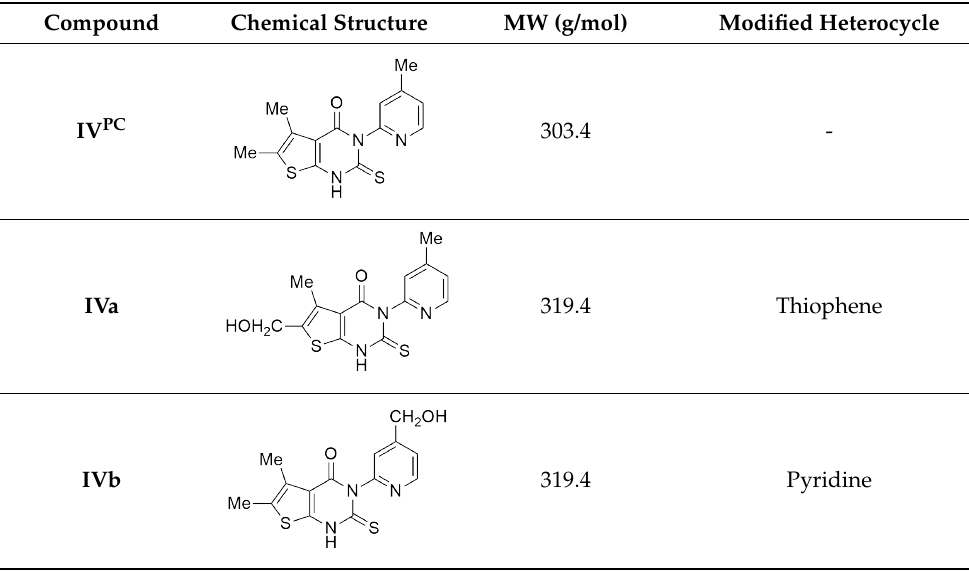
Table 1. Synthesized analogues of lead compound IV PC . The chemical modifications introduced are distributed throughout the three heterocycles, thiophene, pyridine and pyrimidine, as indicated. Compound